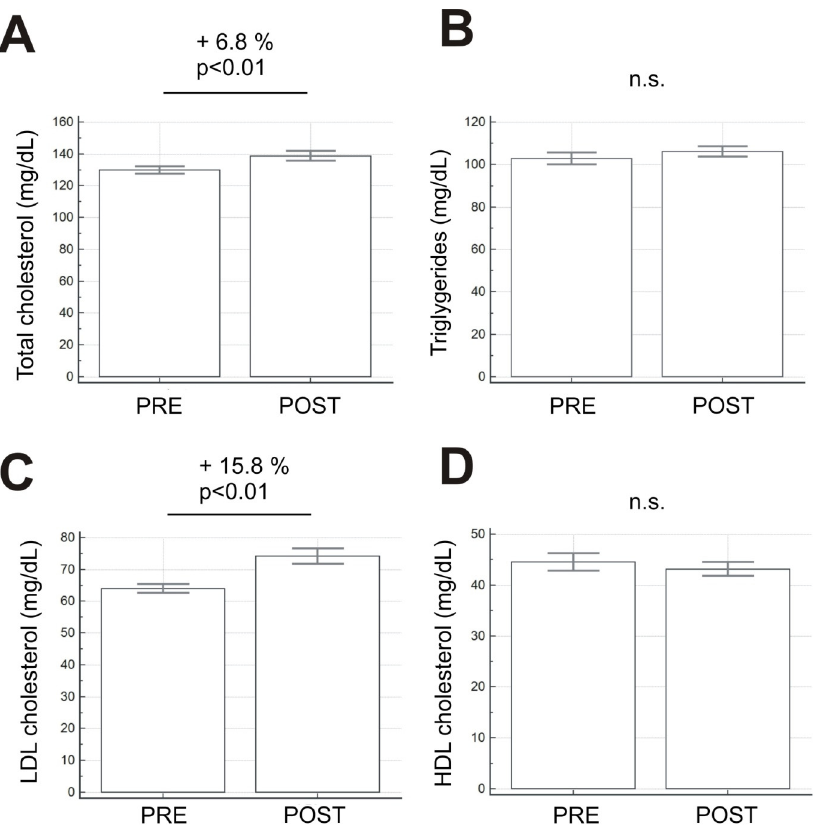
Figure 1. Changes in levels of total cholesterol ( A ), triglycerides ( B ), LDL ( C ) and HDL ( D ) cholesterol at T0 and T1. All values are expressed as mean ± S.E.M. (n.s. = not significant).